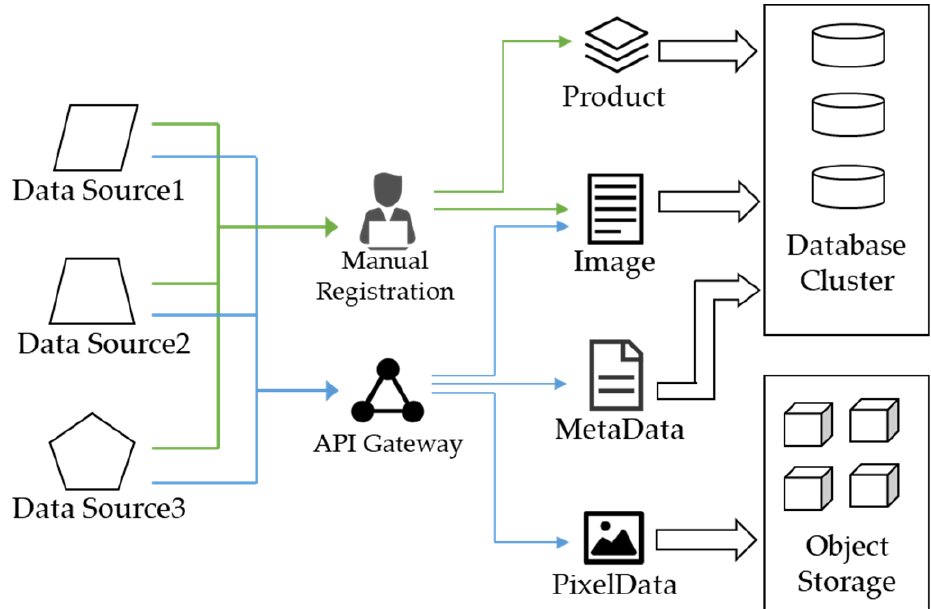
Figure 19. The flow of multi-source heterogeneous remote sensing images integration.